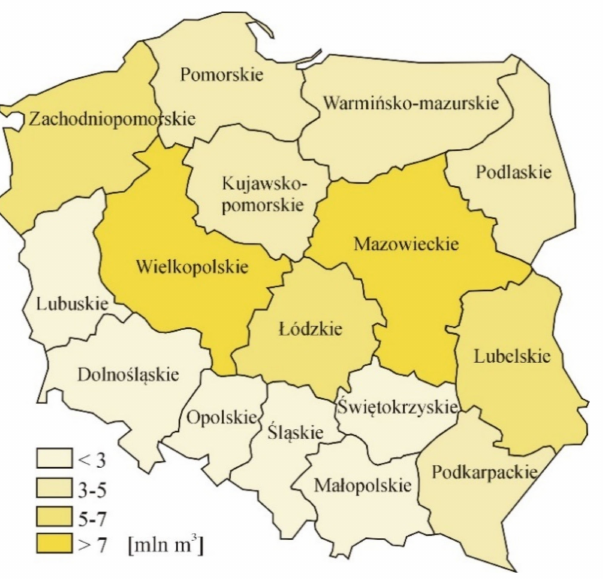
Figure 9. Volume of BM that can be obtained from maize grown on agricultural land in Poland (mln m 3